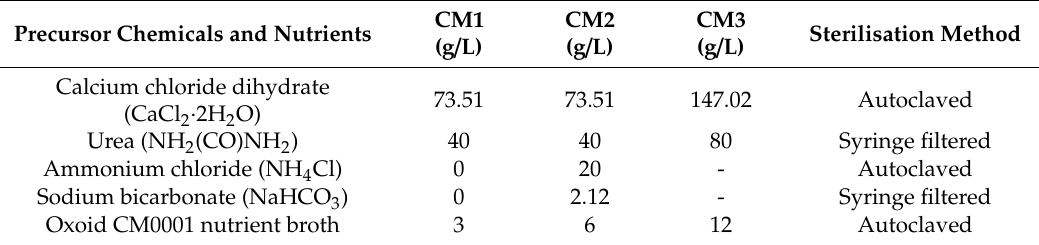
Table 2. Cementation media composition and sterilisation